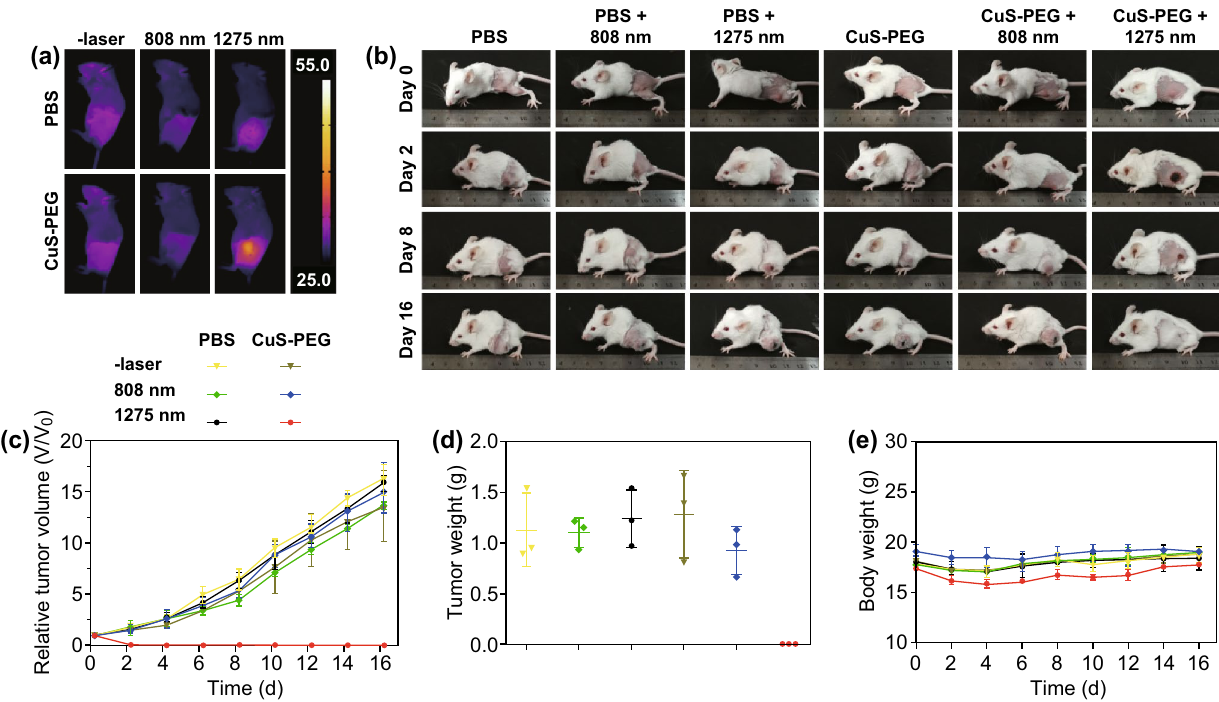
Fig. 5 Comparison of antitumor capabilities in vivo. a Infrared thermal image of mice after different treatments. b Representative pictures of mice after different treatments. c Relative tumor size of mice after different treatments. d Weights of tumors in mice sacrificed after 16-day observation. e Body weights of mice after different treatments. The error bars represent standard deviations ( n = 3 per